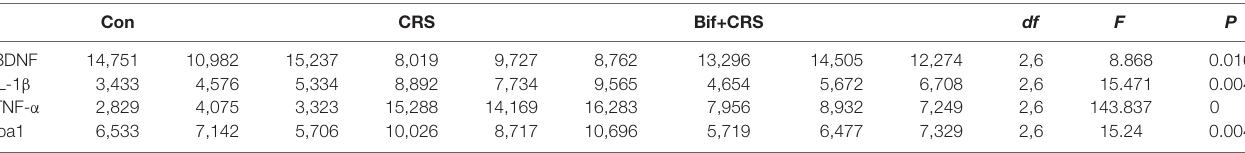
TABLE 6 | Changes in the protein expression of BDNF, IL-1 β , TNF- α and Iba1 in the CA1 region of the hippocampus induced by pretreatment with B. adolescentis . Con CRS Bif+CRS df F P